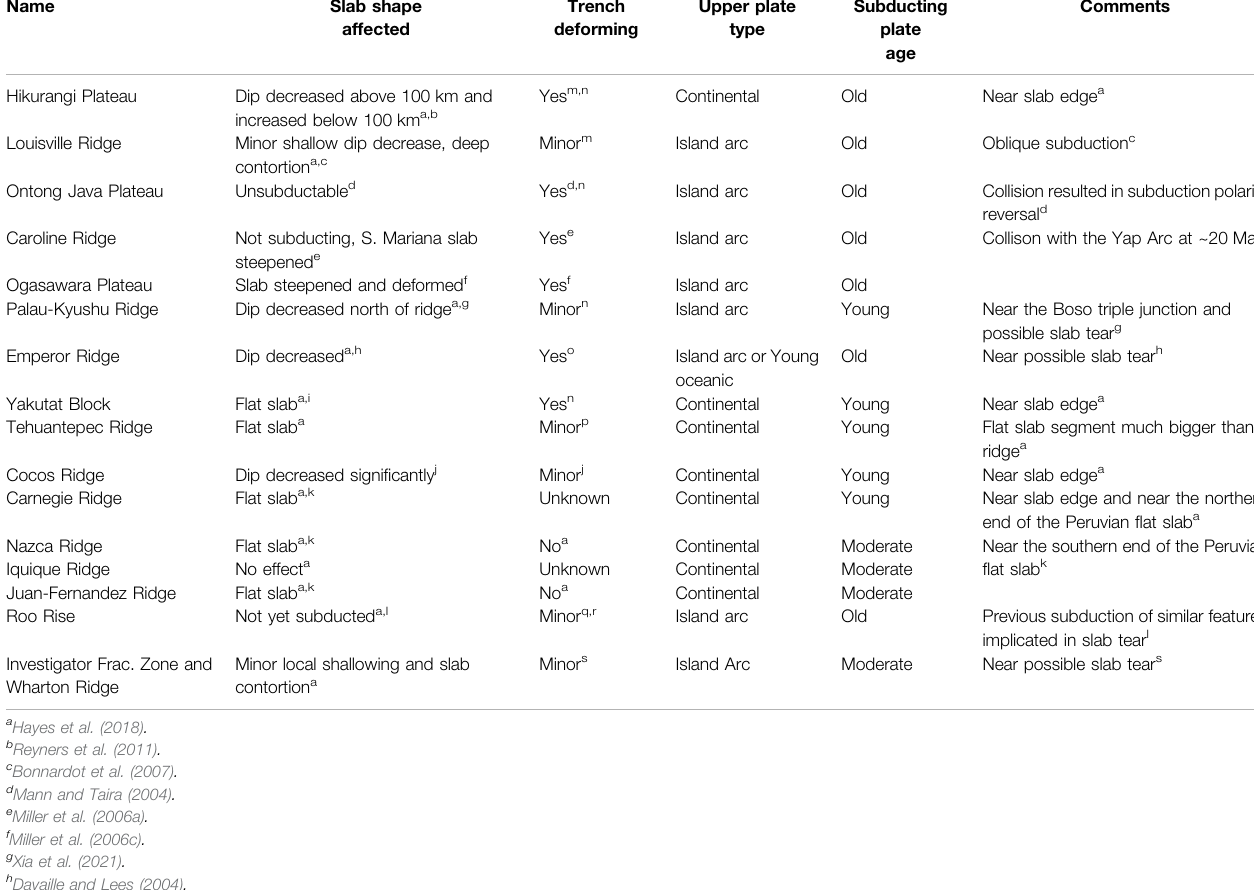
TABLE 3 | Properties of buoyant features discussed in the main text. Superscripts refer to information source.